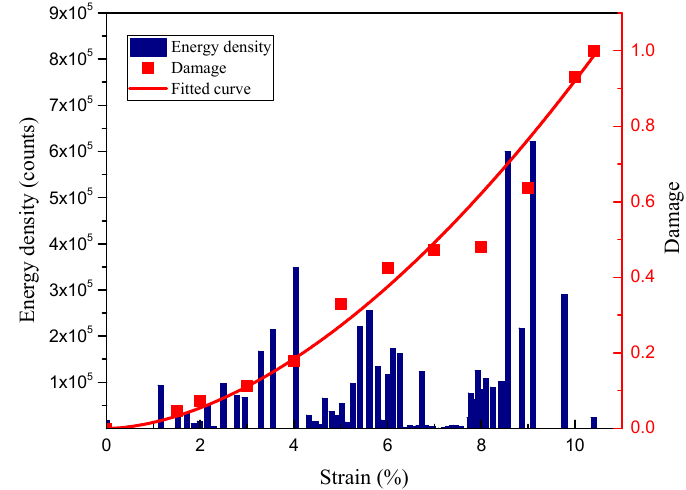
Figure 6. Curves of energy density and damage relative to the strain of the salt rock sample.